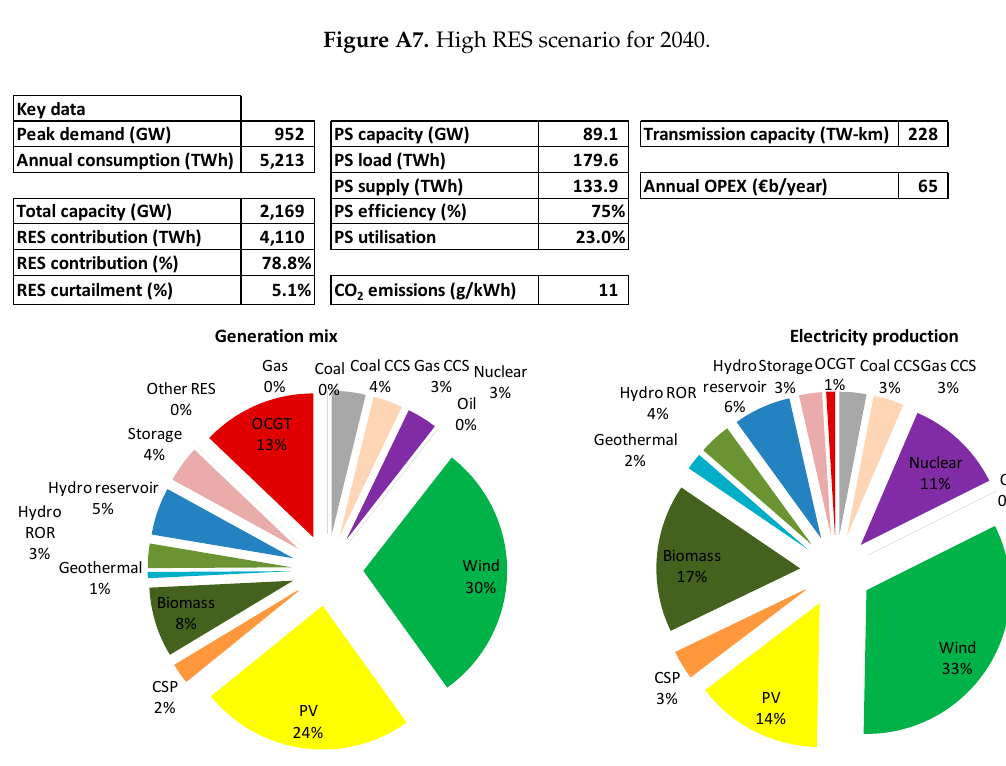
Figure A8. High RES scenario for 2050.